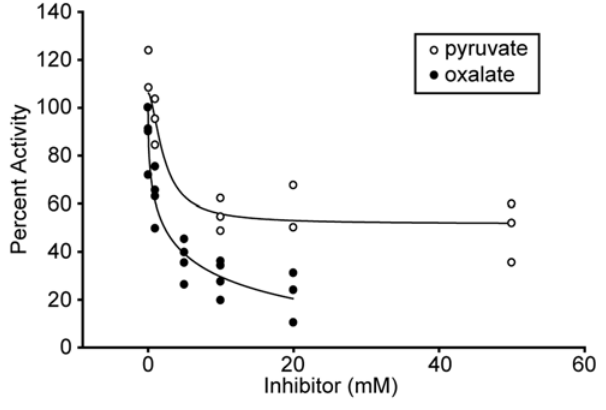
Figure 6. Pyruvate is a poor inhibitor of LctD-his 6 . The ability of pyruvate and oxalate to inhibit LctD-his 6 enzymatic activity was assessed as described in Materials and Methods. 50% inhibition of